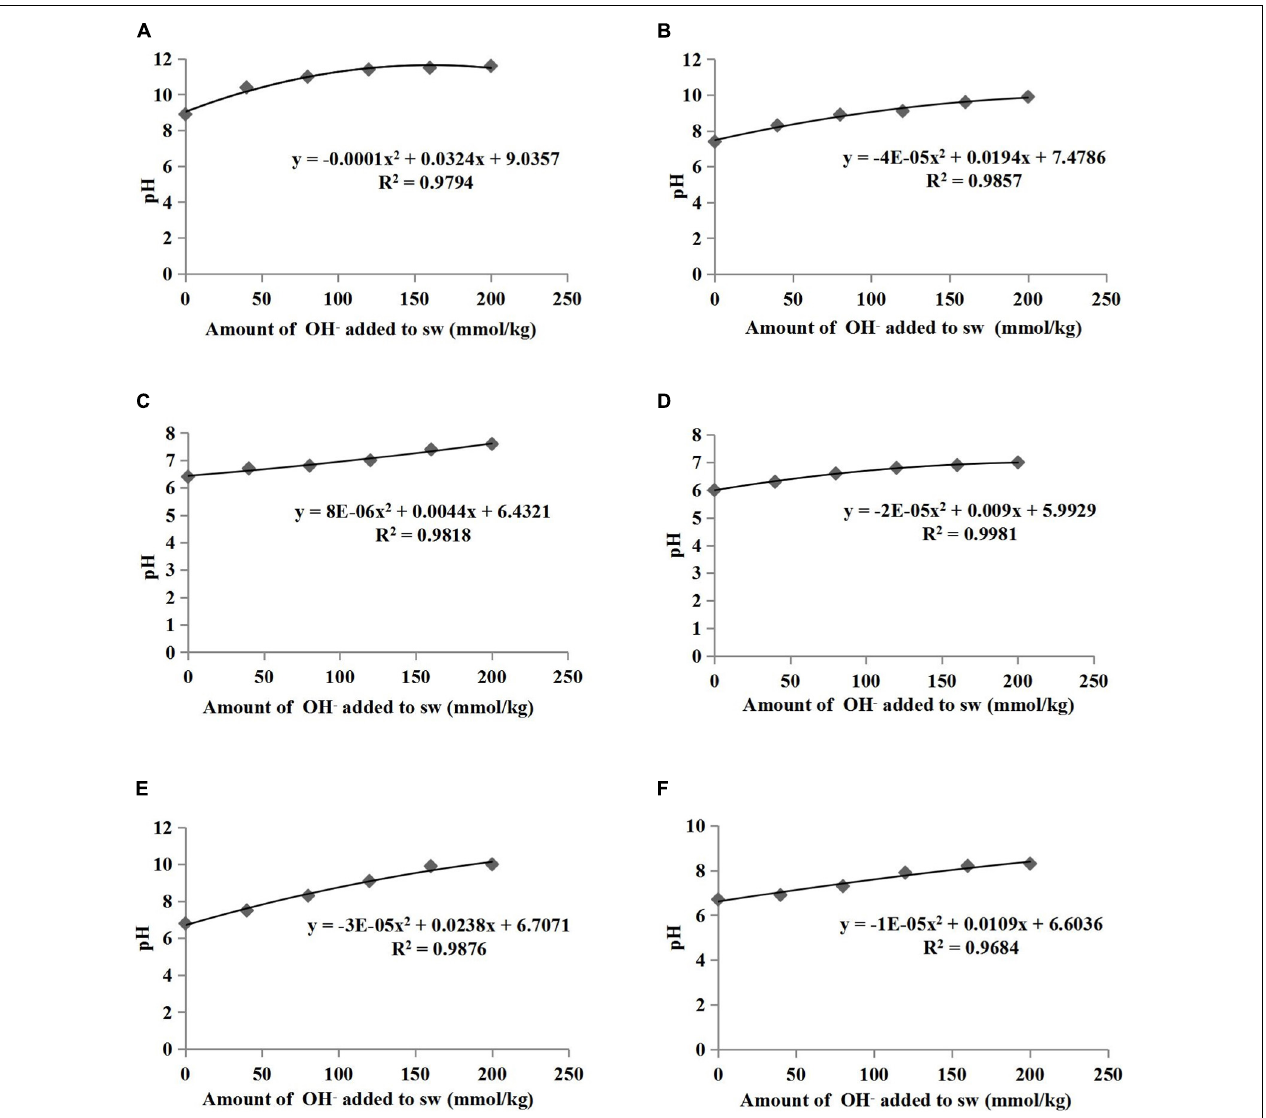
FIGURE 2 | Relationships between the amount of alkali added to substrate weight (sw) and the pH of sand (A) , sand+1% HA (B) , cocopeat (C) , cocopeat+1% HA (D) , 1:1 sand:cocopeat (E) , and 1:1 sand:cocopeat +1% HA (F)